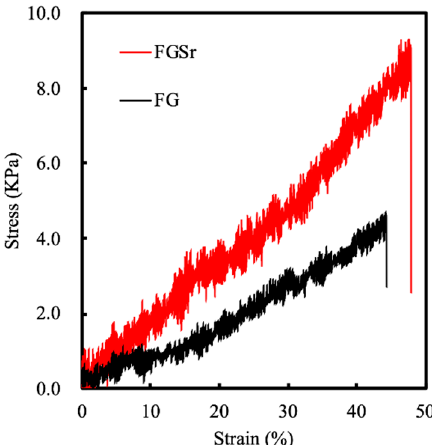
Figure 4. Tensile stress–strain curves of 3D-printed FG and FGSr scaffolds.